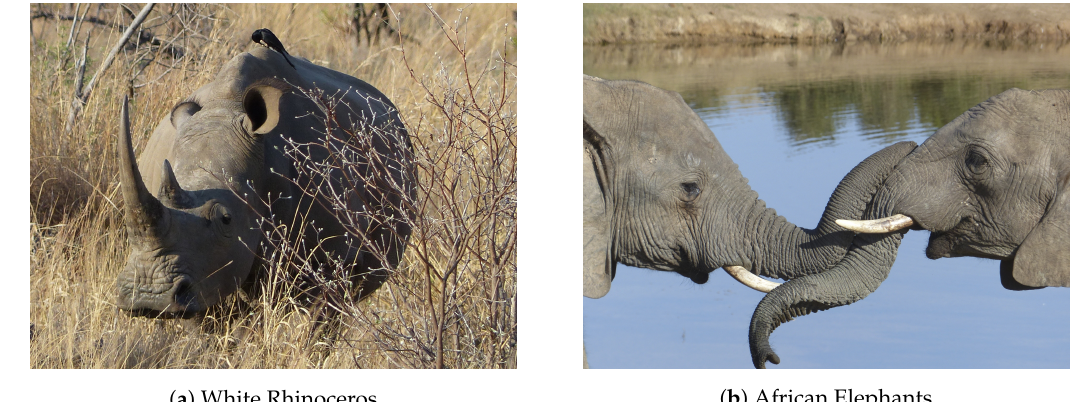
Figure 1. White Rhinoceros and African Elephants in their natural habitats.